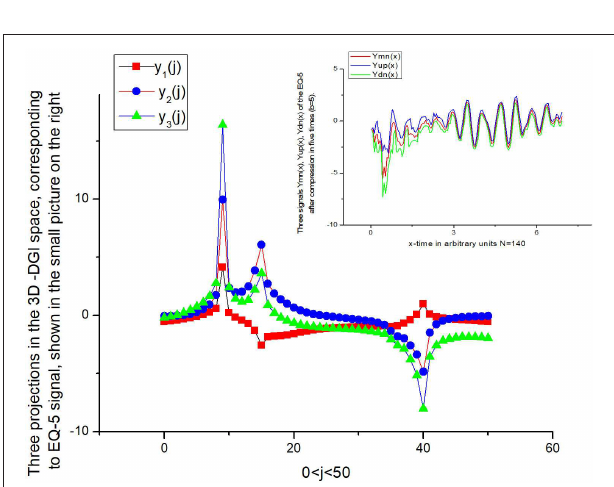
FIGURE 13 | Plots for y 1,2,3 ( j ) of the EQ-4 signal. In spite of their quantitative difference the EQs-1, 3, 4 have the same statistical nature.